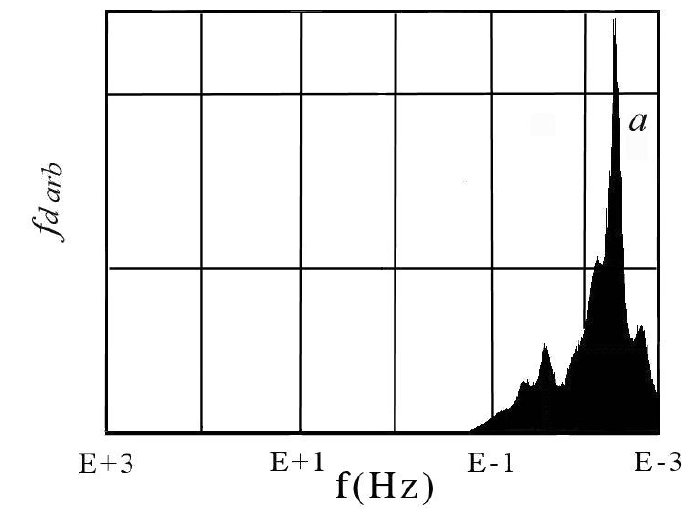
Figure 16. Power spectra and dominant frequency for Warburg impedance at reversible potential. a: 2.5 mHz.